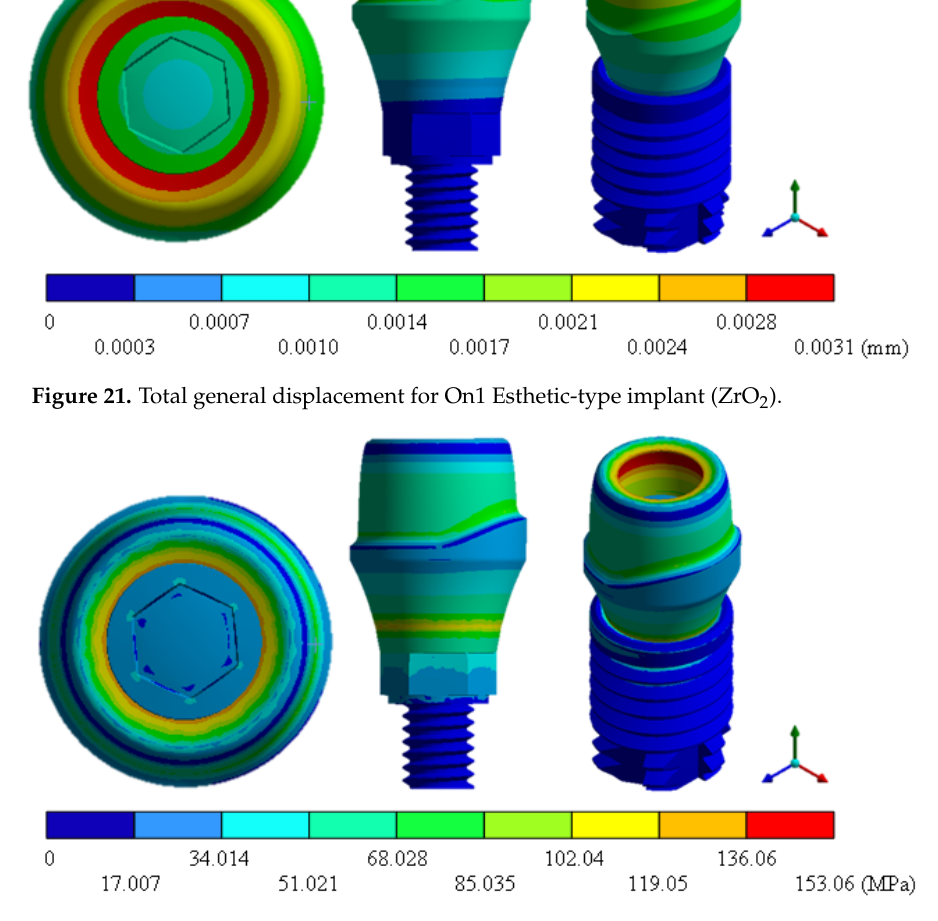
Figure 22. Von Mises stress for On1 Esthetic-type implant (ZrO 2